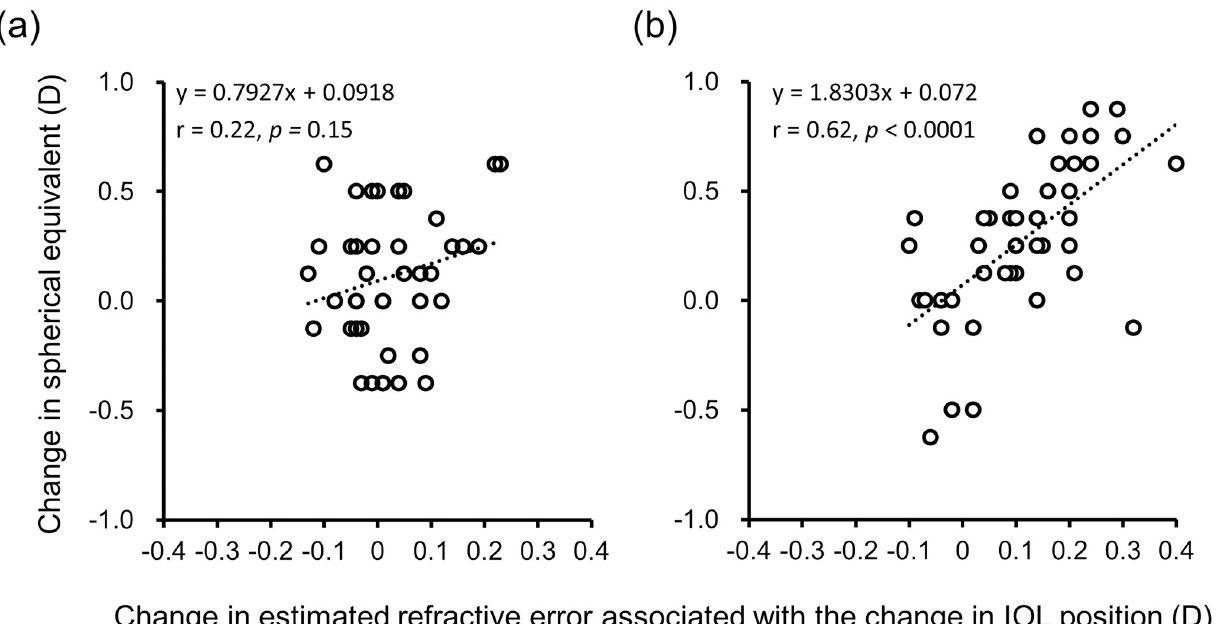
Fig 4. Correlations with the changes in refraction and IOL depth between 4 days and 1 month after cataract surgery: (a) IOL with hinges and (b) IOL without hinges.